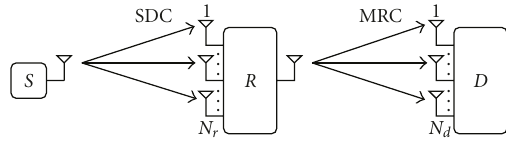
Figure 1: System model: dual-hop MIMO